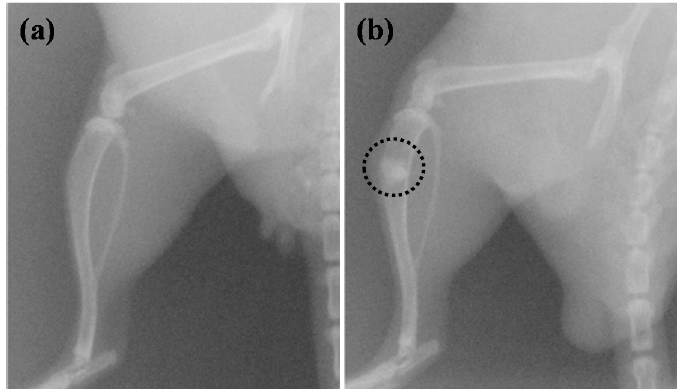
Figure 1. The position of the implanted material in the rat’s right hind leg bones: ( a ) before implantation and ( b ) after implantation (as indicated by the black dash line).